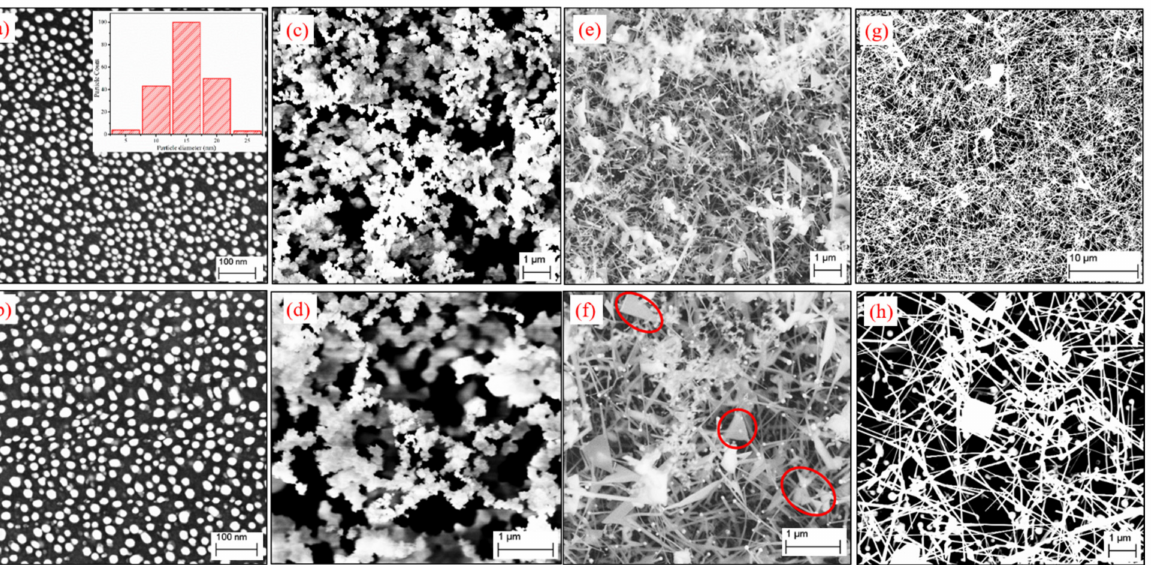
Figure 1. FESEM images of ( a ) Au nanoparticles after thermal dewetting of a 2.9 nm thick Au film at 600 ◦ C for 1 h. The inset shows the size distribution of the produced NPs. FESEM images of the as-grown Ga 2 O 3 nanostructures prepared at ( b ) 800 ◦ C, ( c , d ) 900 ◦ C, ( e , f ) 1000 ◦ C, and ( g , h ) 1100 ◦ C for a growth time of 32 min under a constant Ar flow of 50 sccm. ( c , d ), ( e , f ), and ( g , h ) are for the same growth temperature but at different magnification in